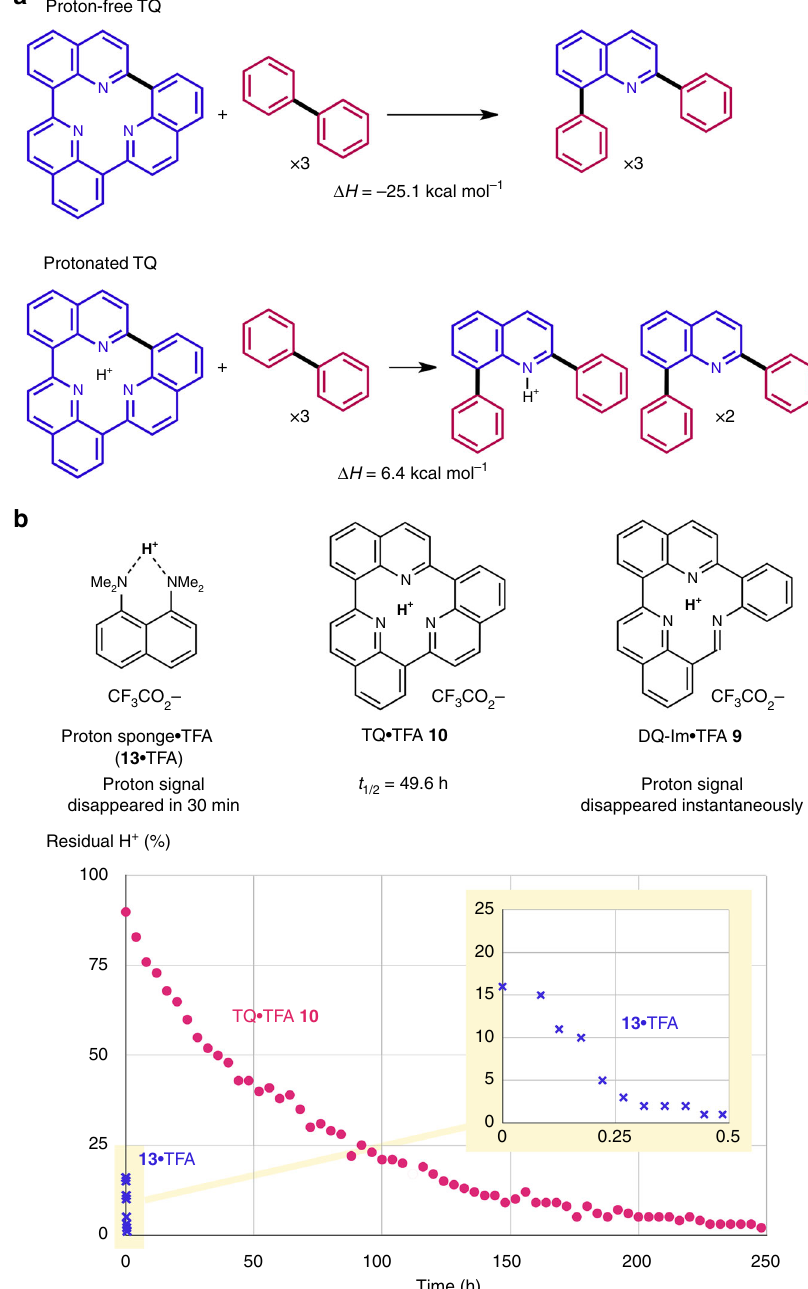
Fig. 4 Unparalleled protophilicity of TQ. a Homodesmotic reactions of proton-free TQ and protonated TQ. Heat-of-formation values were calculated at the ω B97XD/def2-TZVPP/SMD(acetonitrile)//B3LYP-D3/6-31 G(d, p) level of theory. b Retention of the proton of 13 (cid:129) TFA, TQ (cid:129) TFA 10 , and DQ-Im (cid:129) TFA 9 in CD 3 OD (>10 4 equiv with respect to the solute) at 25 °C. Kinetic pro fi le of the H + /D + exchange monitored for 13 (cid:129) TFA and TQ (cid:129) TFA 10 by 1 H